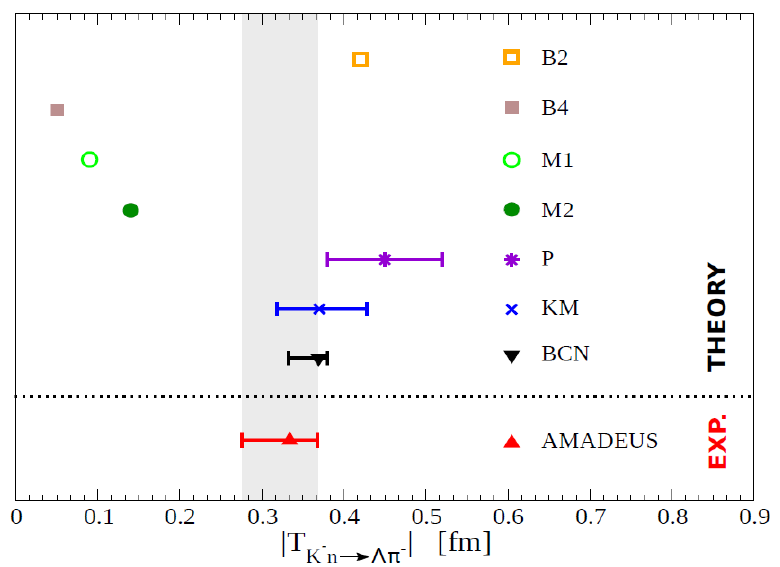
Figure 1. Modulus of the measured non resonant K − n → Λ π − transition amplitude compared with theoretical calculations, see details in the text. Figure is adapted from Ref.